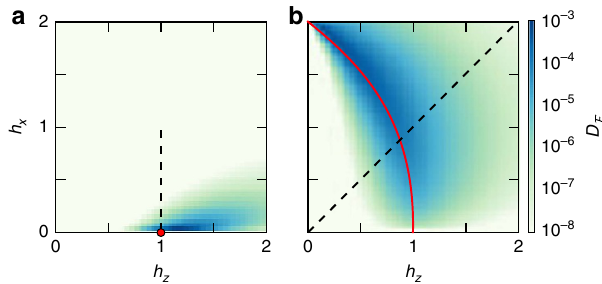
Figure 1 | Interaction distance across the phase diagram of the quantum Ising model. ( a ) The FM and ( b ) the AFM model at system size L ¼ 16 with periodic boundary conditions. The interaction distance (log scale) takes non-negligible values only in the vicinity of the critical point and critical line which are sketched in red. The scaling behaviour of D F along the dashed lines is given in Fig.